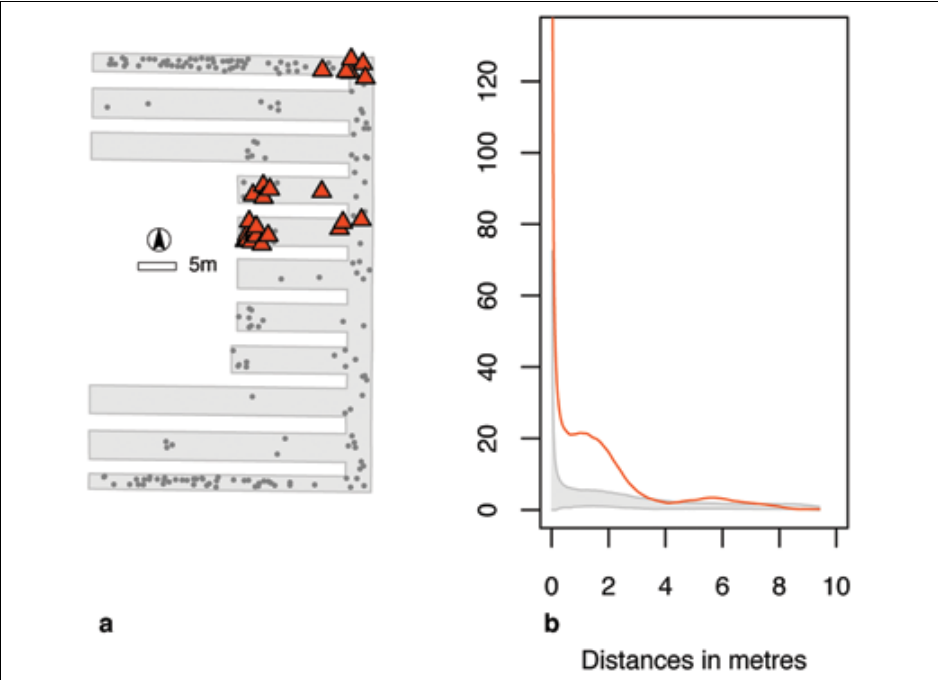
Fig. 7: Plots of (a) the spatial distribution of one of the subgroups of triggers, showing a clus- tering in the north-east of the pit, and (b) a statistical treatment of this evidence that formally confirms this pattern and the 4m radius zones over which it most obviously